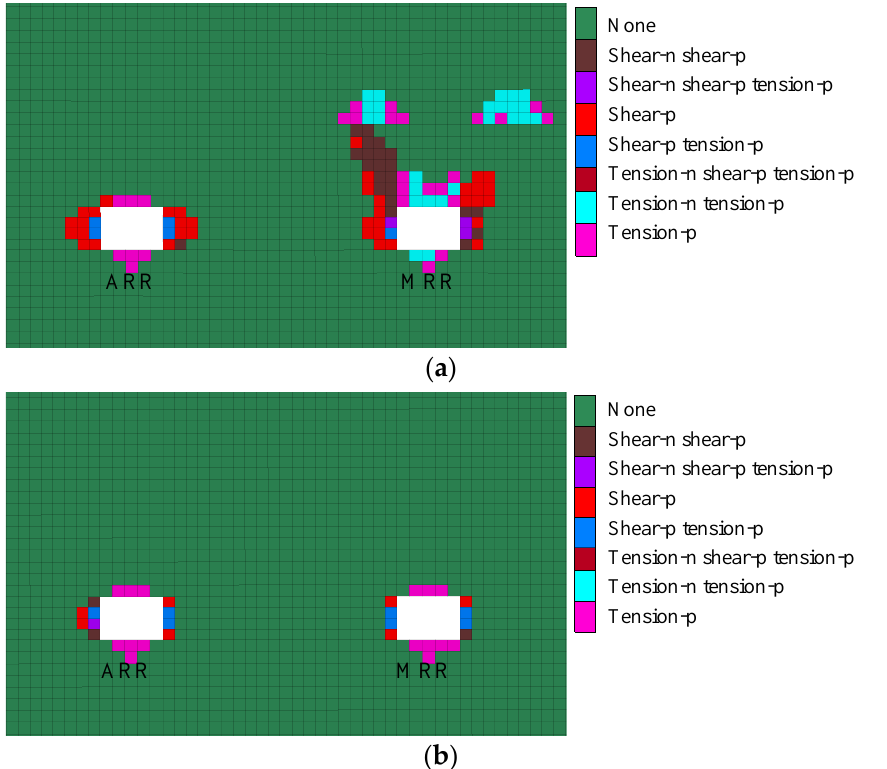
Figure 8. Distribution of plastic zone of surrounding rock of retracement roadway: ( a ) horizontal distance = 15 m; ( b ) horizontal distance = − 30